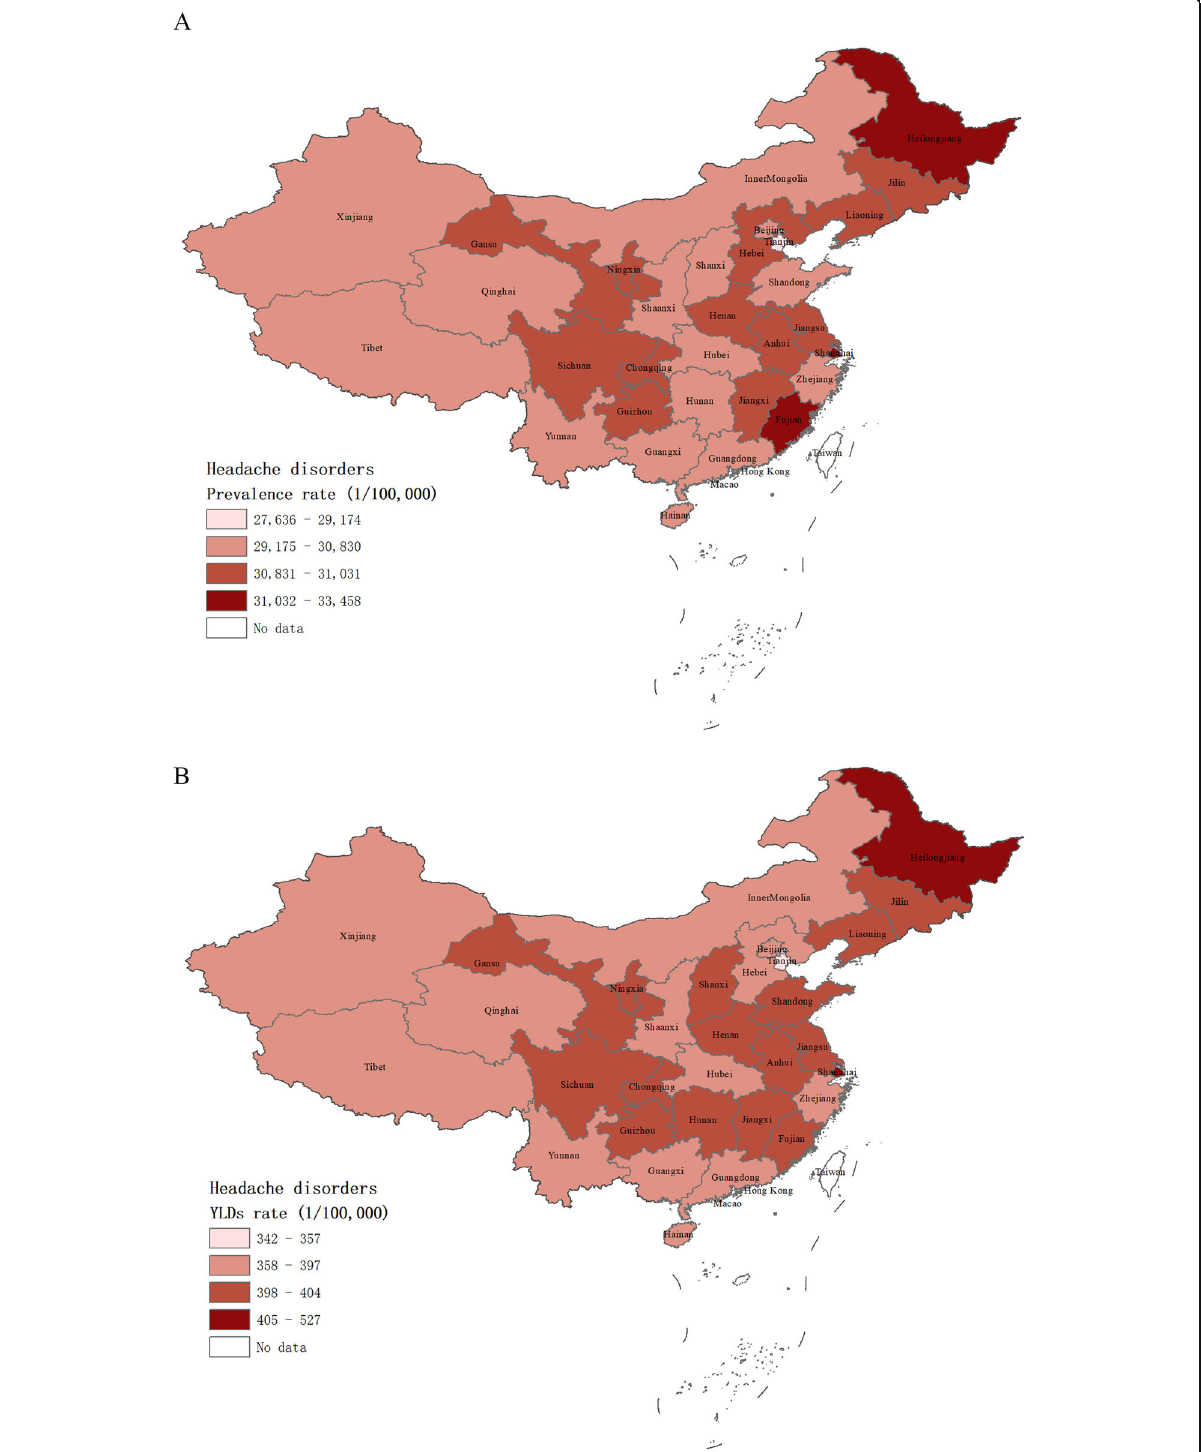
Fig. 3 The age-standardized prevalence and YLDs rate for headache disorders in 2017 by provinces of China. Abbreviation: YLDs: years of life lived with disability. Note: a the age-standardized prevalence rate from headache disorders in 2017 by provinces of China; b the age-standardized YLDs rate from headache disorders in 2017 by provinces of